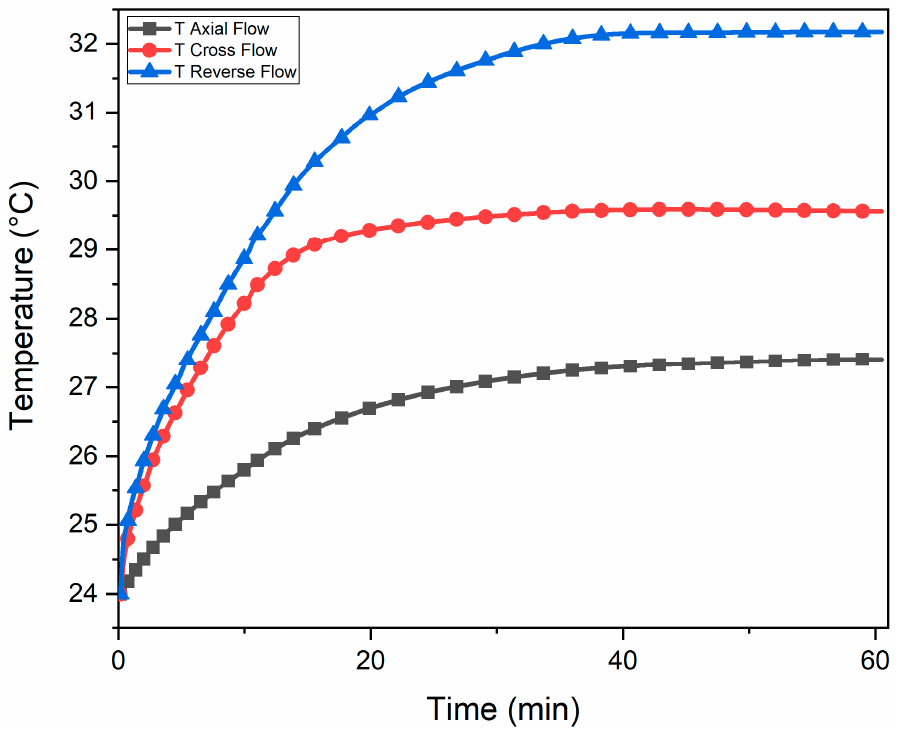
Figure 17. Cavity configuration comparison at a power level of 20 W.